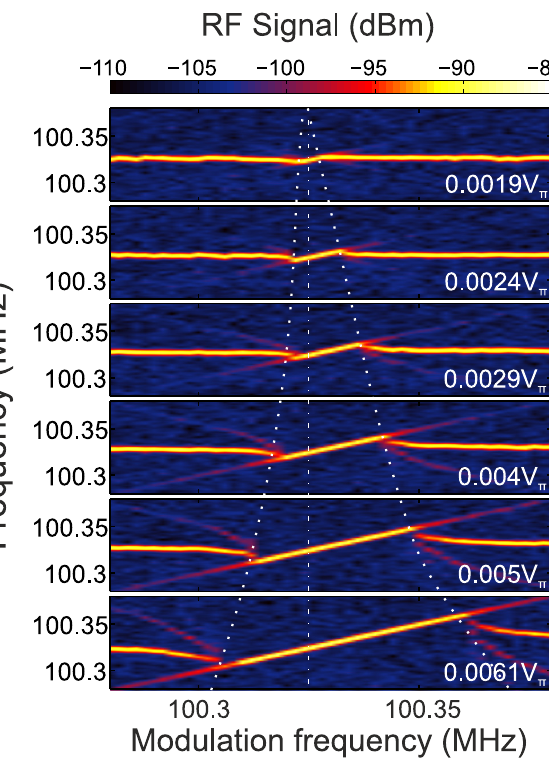
Figure 4: Phonon lasing oscillation frequency. (Color online) Colormapsofthepowerspectraldensity(PSD)oflighttransmittedat the wavelength of the probe laser for modulation amplitudes from V AC =0.0019 V π to V AC =0.0061 V π .Thedashedwhitelinesareguides to the eye and help to visualize the asymmetric growth of the Arnold tongue with respect to the free-running oscillation frequency at f OMO,0 = 100.322